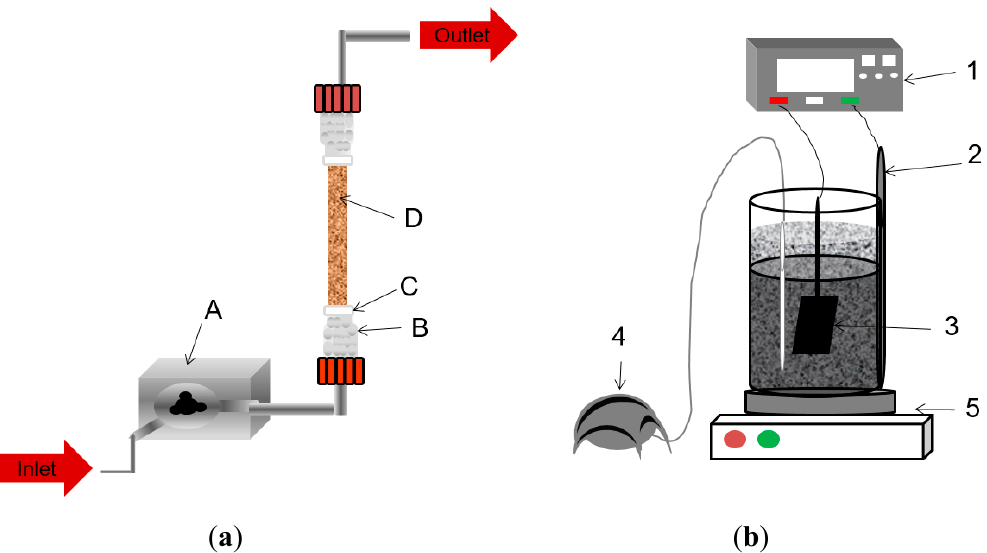
Figure 6. Experimental set-up ( a ) column reactor schema: A: peristaltic pump, B: glass beads, C: nylon sponge, D: S-Fe; ( b ) slurry reactor schema. 1: electric field supply, 2: cathode, 3: anode, 4: air pump, 5: magnetic stirrer.